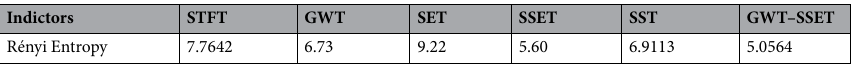
Table 1. Rényi entropy of TFA results calculated by different methods for simulated signal.